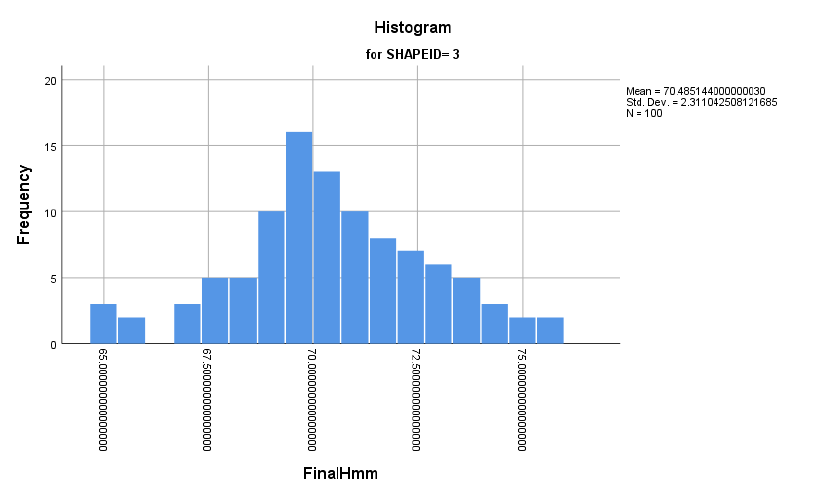
Figure A8. Grow height adjustment for 70